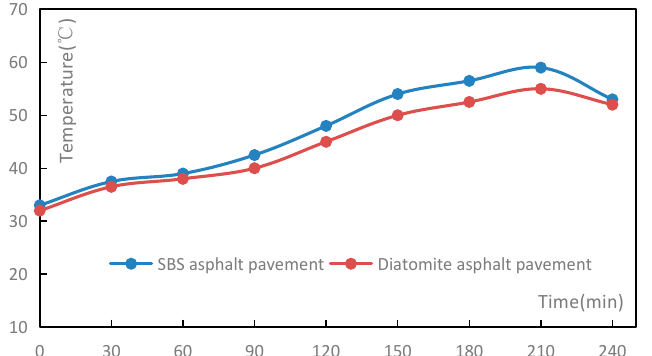
Figure 7. Comparison of road surface temperature of two asphalt mixtures at ambient temperature of 38 °C.